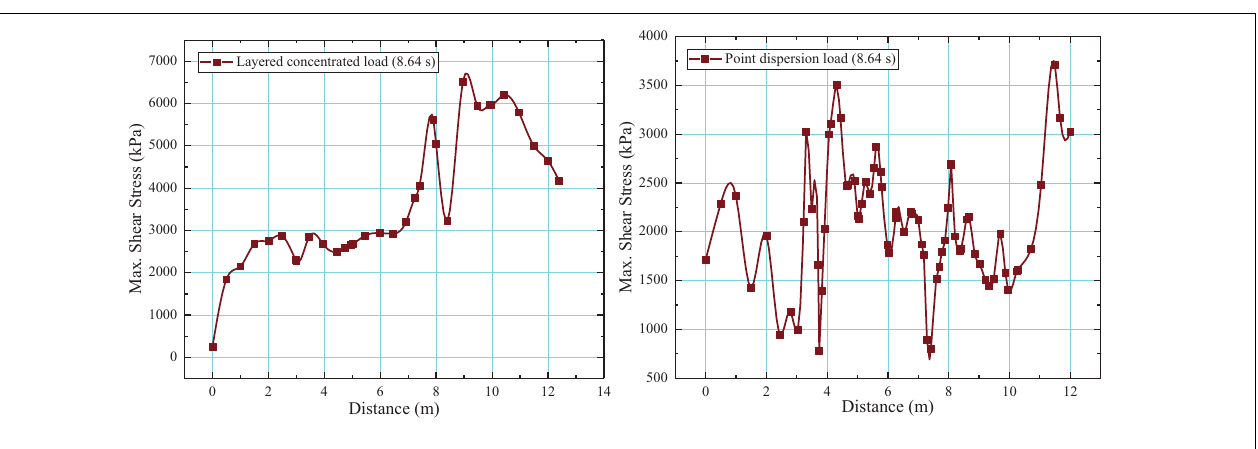
FIGURE 8 | Variation of maximum transverse shear